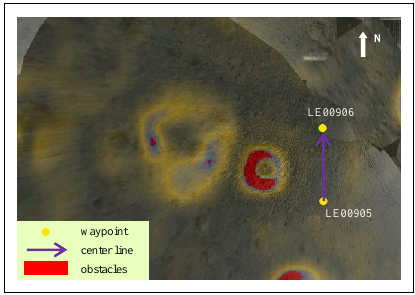
Figure 8. Comprehensive cost map at waypoint LE00905 and a searched path calculated with its support.